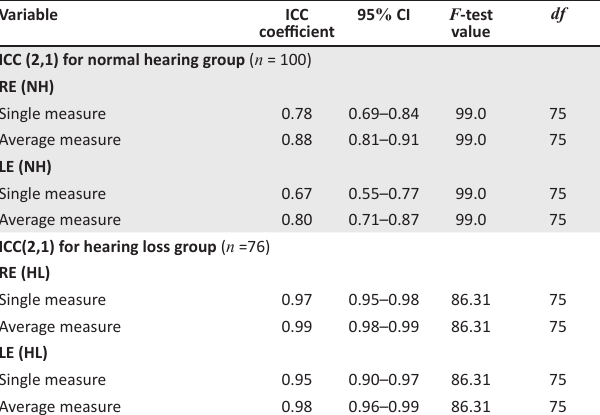
TABLE 2: Intraclass correlation coefficient (2, 1) results for agreement between pure tone average and isiZulu speech reception threshold measures for participants with normal hearing and with hearing loss.